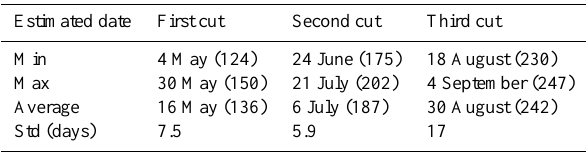
Figure 4. The first mowing date (in DOY) mapped from the simplified algorithm described in section 3.2, .LAI (m²/m²) map obtained from the eq 2, on DOY 151 (31 May 2006)